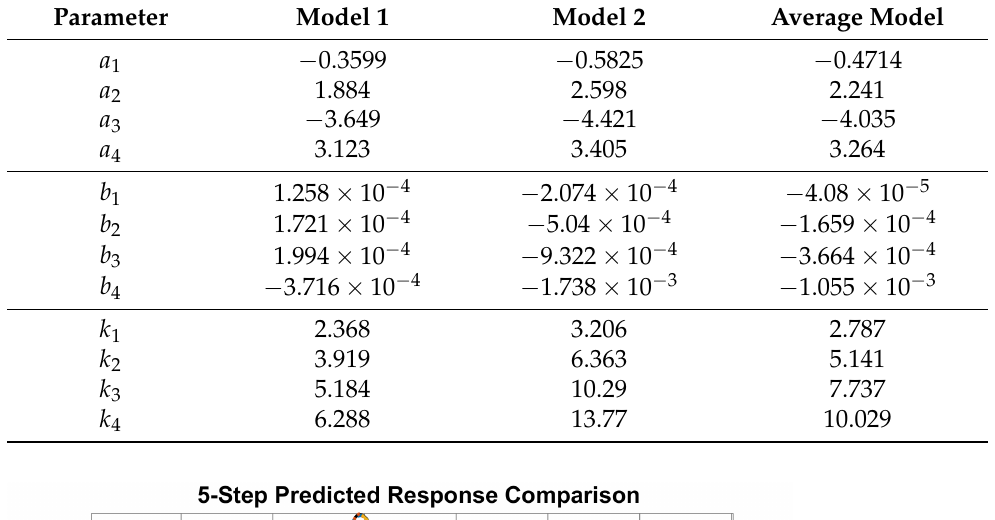
Table 2. Examples of identified models and the average model comparison.